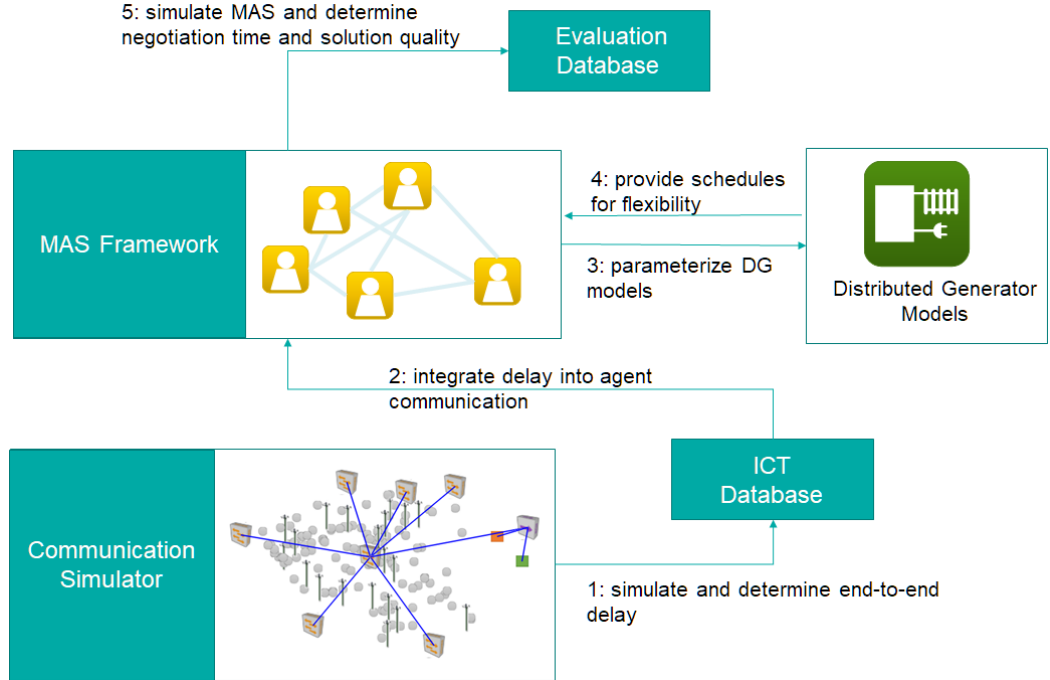
Figure 2. Architecture of the simulation